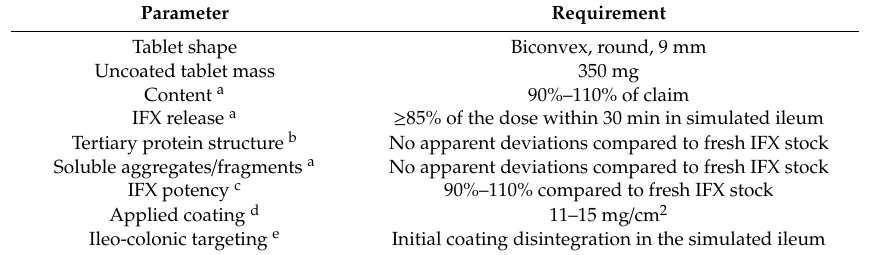
Table 1. Target product profile of the ileo-colonic-targeted infliximab (IFX) tablets (ColoPulse-IFX).